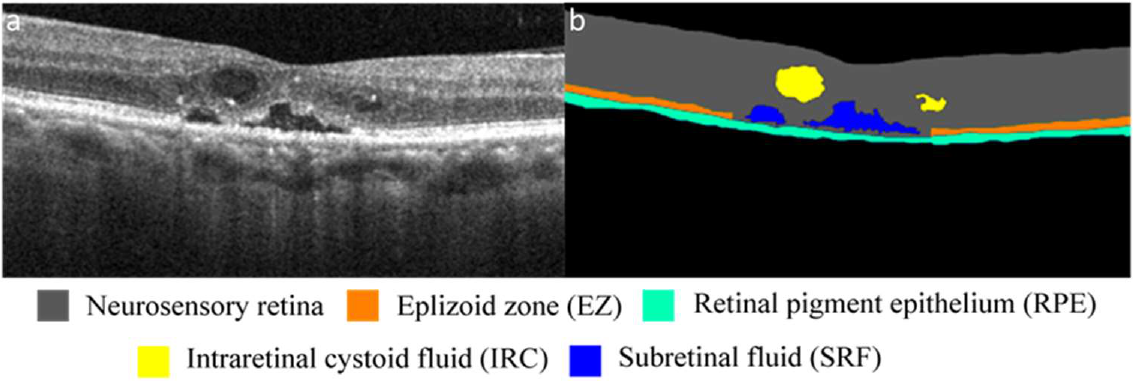
Figure 2. ( a ) OCT image of retina of patient with DME. ( b ) Segmentation of OCT image indicating, through color coding, different retinal structures and features.